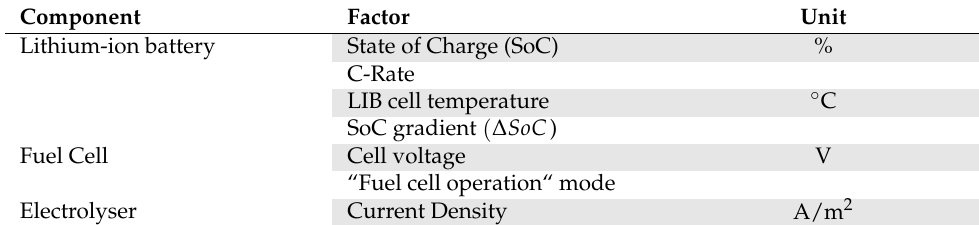
Table 3. Parameters used for the calculation of the degradation.